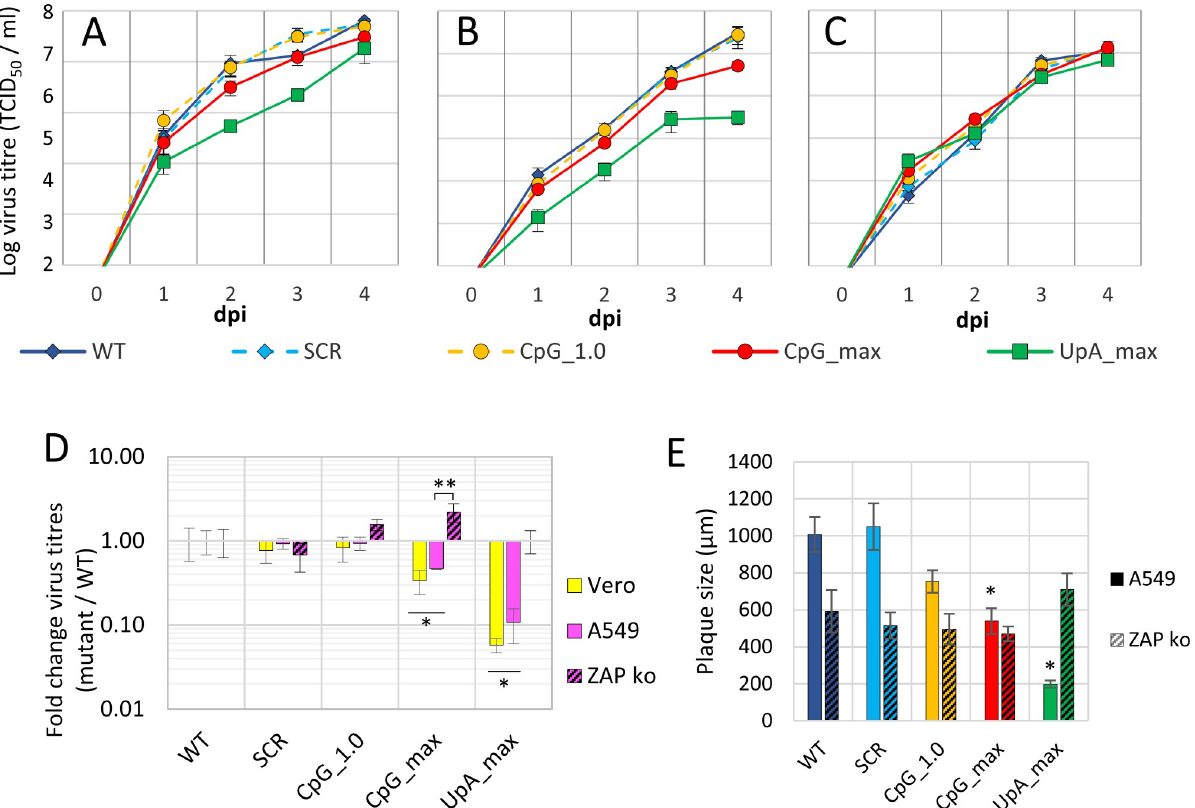
Fig 2. Replication of ZIKV with increased UpA and CpG dinucleotides is restricted in vertebrate cell culture. Vertebrate Vero E6 cells (A) , A549 cells (B), and A549 ZAP knockout cells (C) were infected with the mutant ZIKV viruses at 1 RNA/cell. At the indicated dpi, the 50% tissue culture infectious dose was determined by end-point dilution assays. (D) Relative replication of mutant viruses was calculated by dividing mutant over WT virus titers at 2 dpi. Data points represent the average of a total of 4 independent experiments, compiled of 2 experiments performed for each of 2 independently rescued virus populations. The error bars indicate 1 standard error of the mean. Single asterisks highlight significant differences in WT vertebrate cells from WT ZIKV and 2 asterisks the difference between A549 cells and A549 ZAP knockout cells (two-way ANOVA, FDR adjusted p < 0.05). (E) Average plaque size measured in A549 and A549 ZAP knockout cells 3 dpi with ZIKV or indicated mutant viruses. After removal of the overlay, cells were fixed and stained for ZIKV E protein. Micrographs were taken from plaques from 2 independent experiments. The plaque diameter was measured using the Axiovision software. Data points represent the average plaque size, error bars indicate 1 standard error of the mean, and asterisks highlight significant difference from WT (one-way ANOVA with Dunnett’s post hoc test, p < 0.05). Please refer to S1 Data for the numerical values underlying this figure. dpi, days postinfection; FDR, false discovery rate; ko, knockout; SCR, scrambled control virus; WT, wild-type; ZAP, zinc- finger antiviral protein; ZIKV, Zika